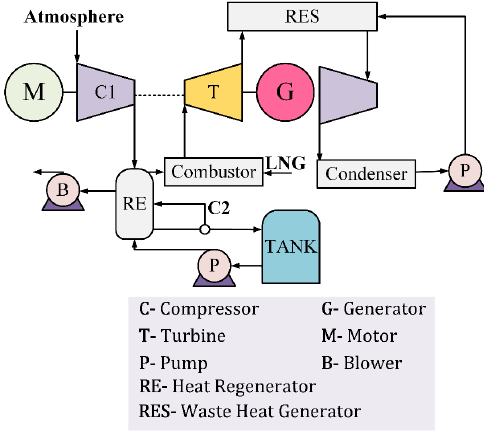
Figure 8. Schematic diagram of liquid air energy storage (LAES) system, where air is liquefied under pressure and stored at low temperature, and then expanded into gaseous form again at high temperature [37].